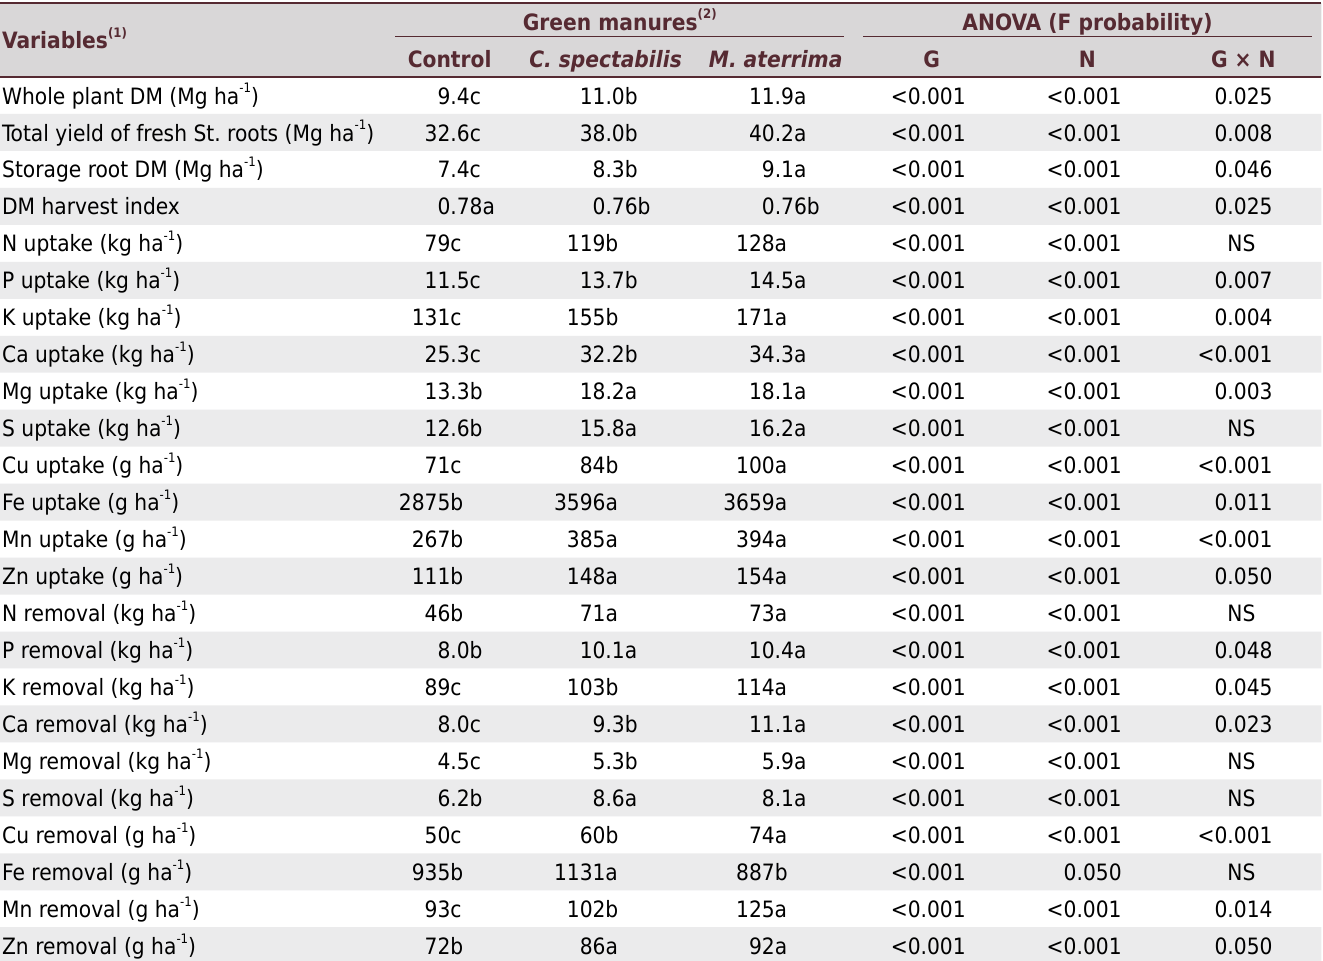
Table 4. Whole plant dry matter (DM) accumulation at harvest, total yield of fresh storage roots, storage root DM accumulation, DM harvest index nutrient uptake, and removal by sweet potato in response to green manure cultivation. Data are the means of